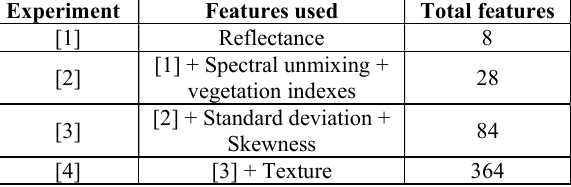
Table 4: Features used and number of total features used in each of the four experiments carried out on this